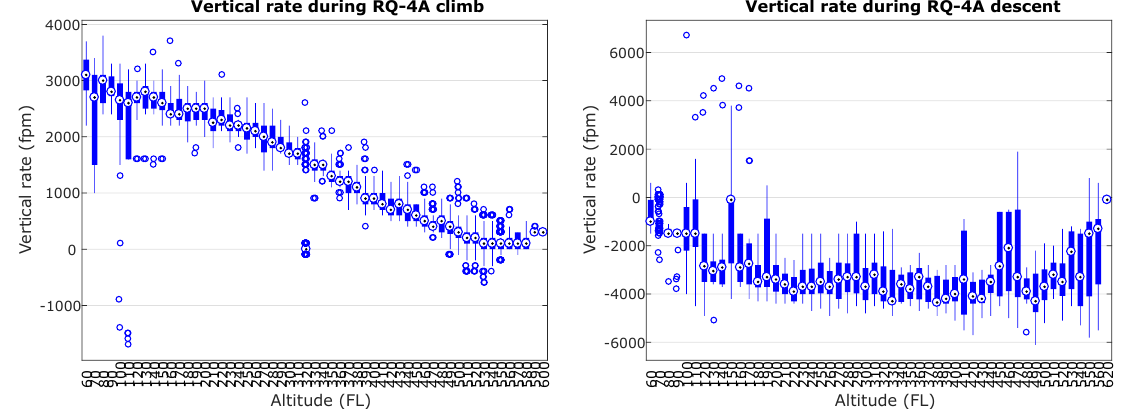
Figure 10. Box plot analysis for vertical rate during climb and descent operations.